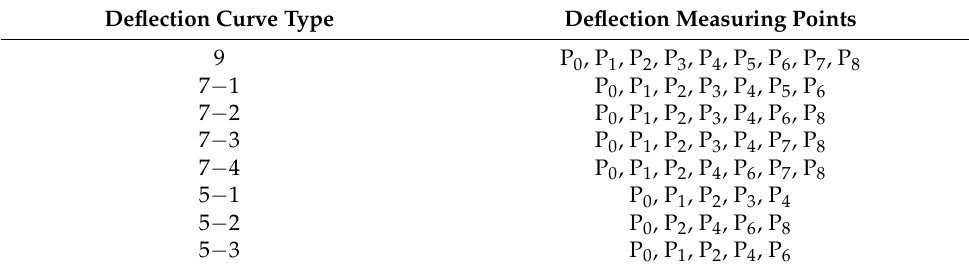
Table 5. The measuring points configurations of eight types of deflection curves.